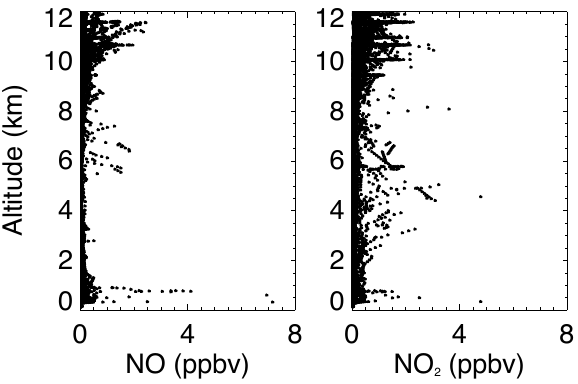
enhancements of LtNO x are likely in the lower